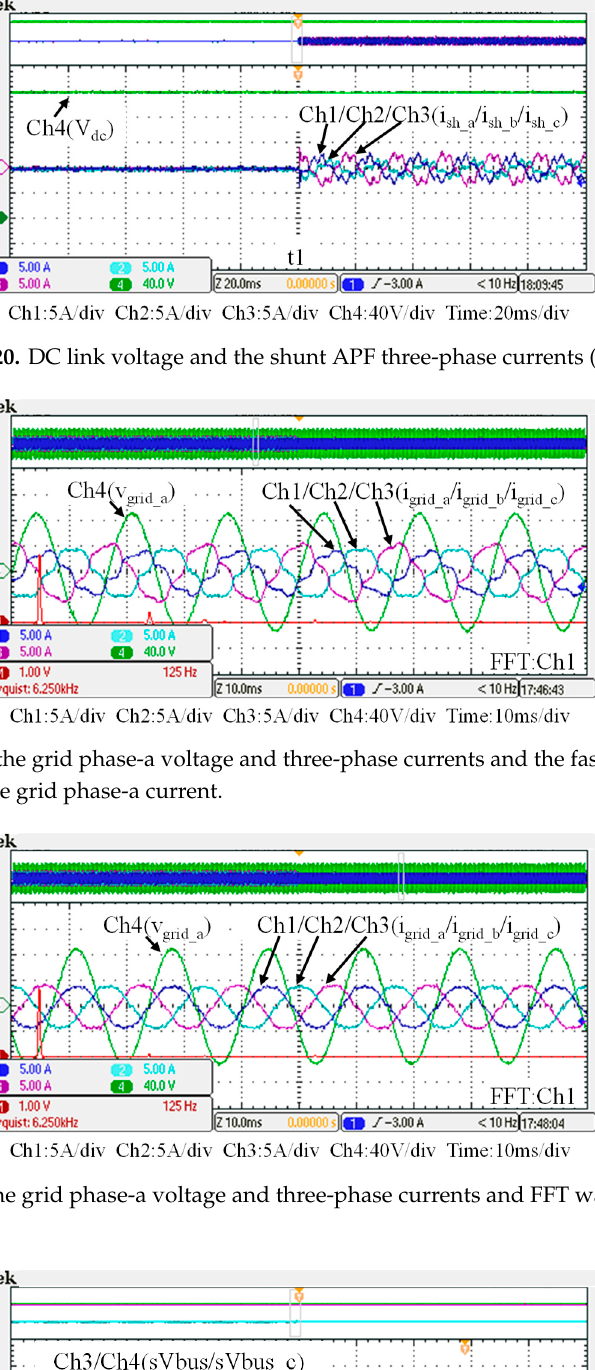
Figure 19. Grid phase-a voltage and three-phase currents (t 0 –t 2 ).